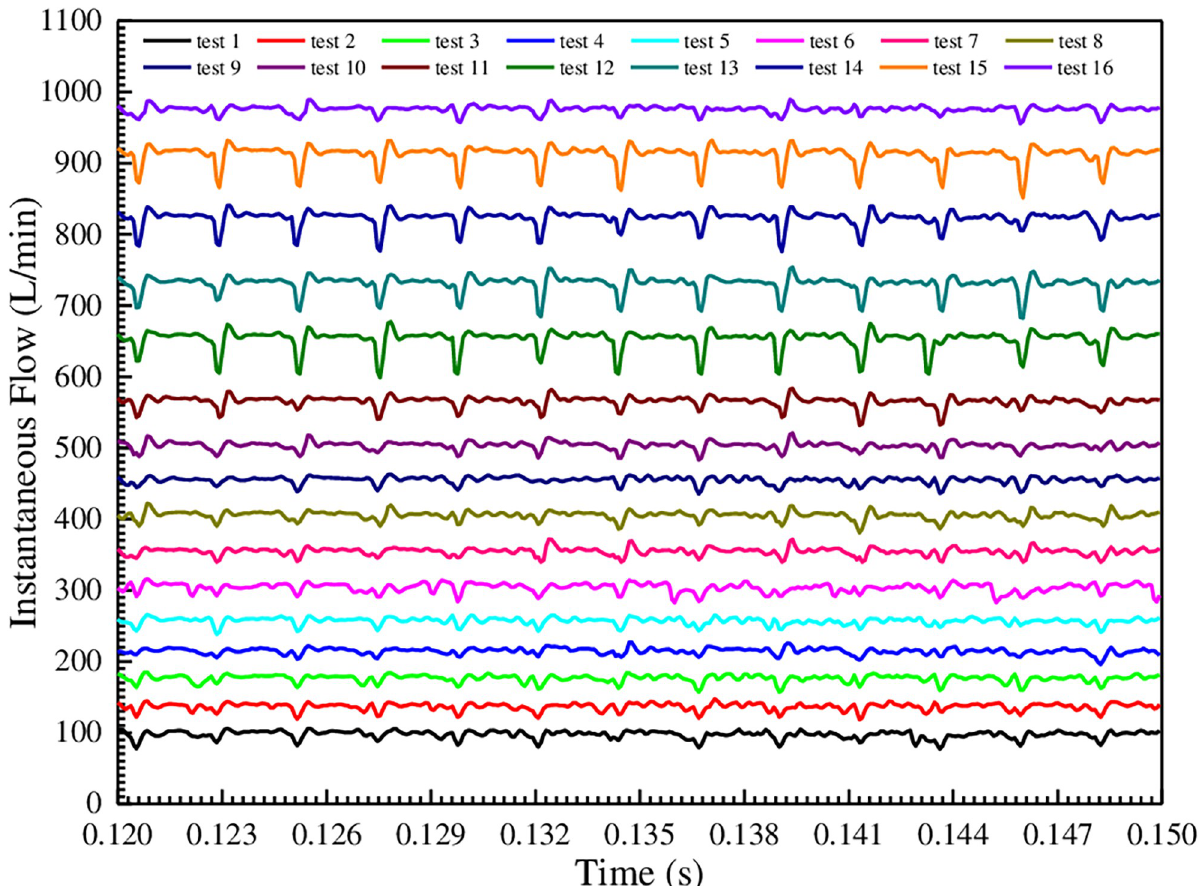
Fig 10. Comparison of instantaneous flow curves under different test conditions.